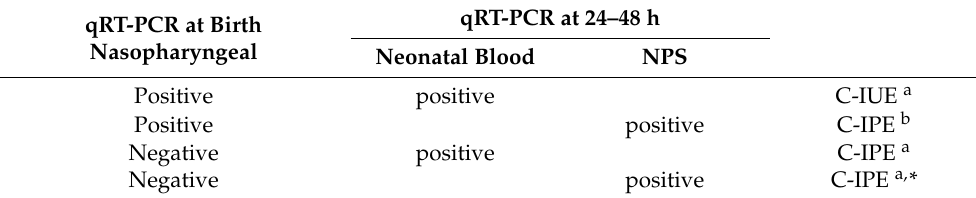
Table 4. The proposed algorithm in diagnosing vertical